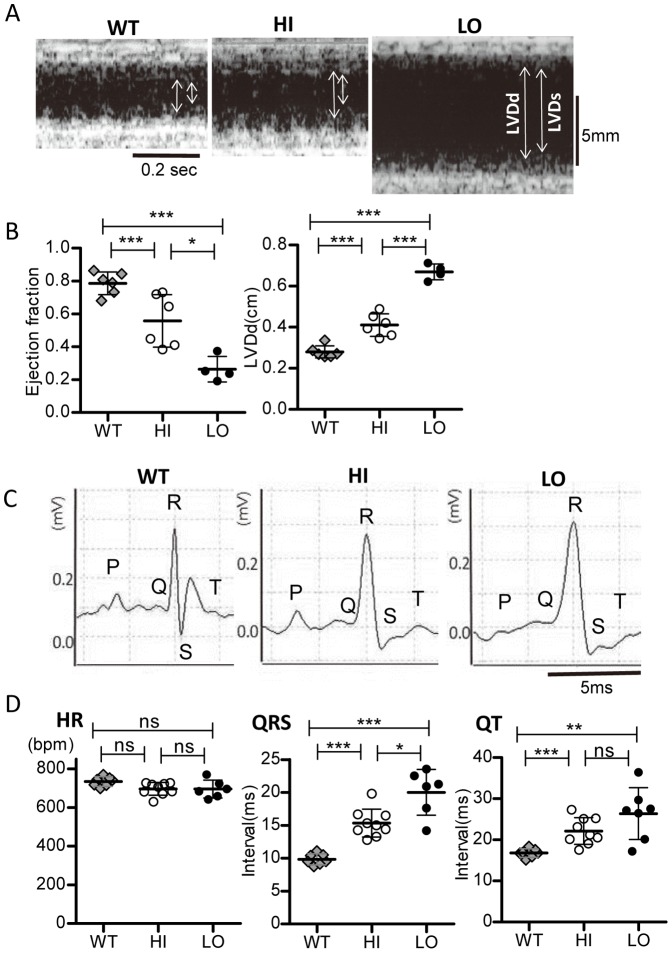
Echocardiography and ECG data from WT and DCM mice.
A. Typical M-mode ultrasound cardiogram obtained from conscious WT and HI and LO DCM mice. B. Average LVDd (left) and EF (right). C
. Typical ECG traces from WT and HI and LO DCM mice. D. Comparison of average heart rate (left), QRS (middle), and QT intervals (right) determined from conscious mice. Bars are mean±SD. *P<0.05, **P<0.01, ***P<0.001; ns: not significant.